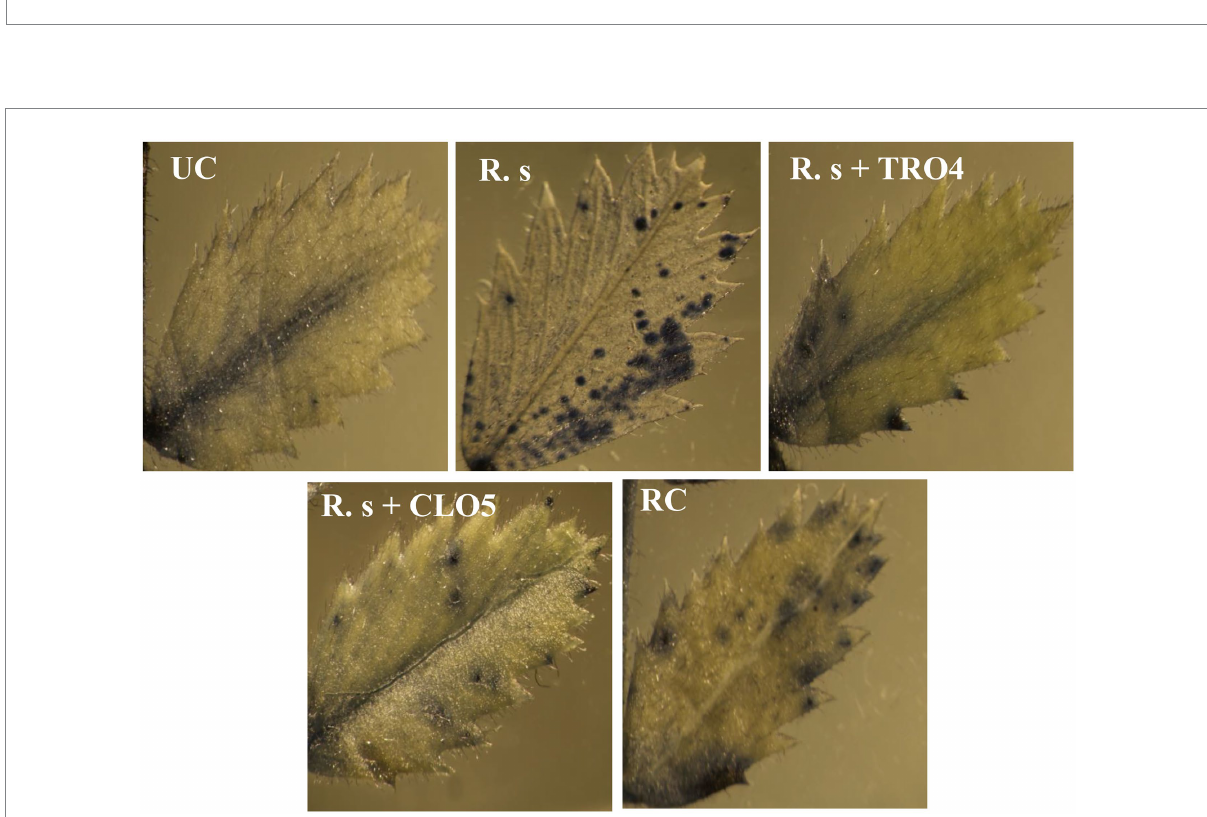
FIGURE 6 Visualization of accumulation of superoxide radicals in chickpea leaves under a stereomicroscope. UC, Un-inoculated control in which neither pathogen nor bacterial strain inoculated; R.s, Rhizoctonia solani ; S.r, Sclerotium rolfsii ; F. o, Fusarium oxysporum f. sp. ciceri ; RC, Resistant